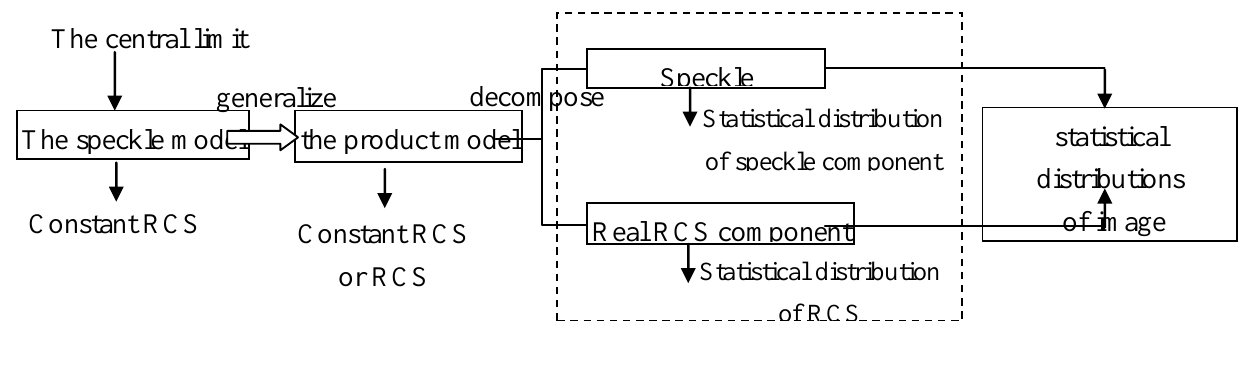
Figure 3. Process of developing a statistical model from the product